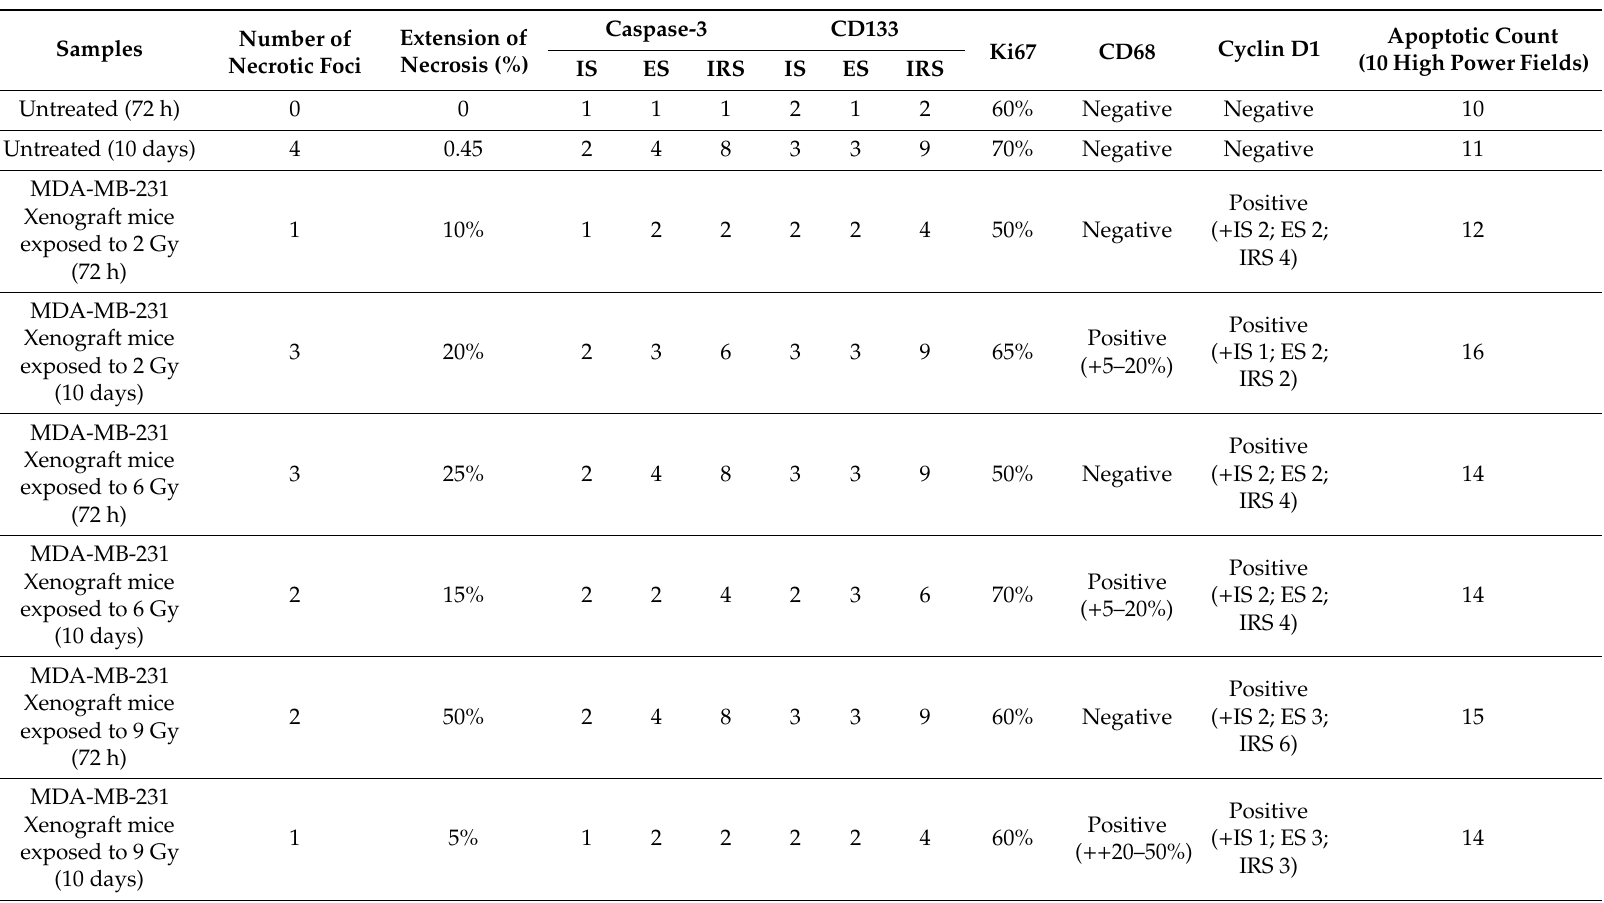
Table 1. Immunohistochemical tumor